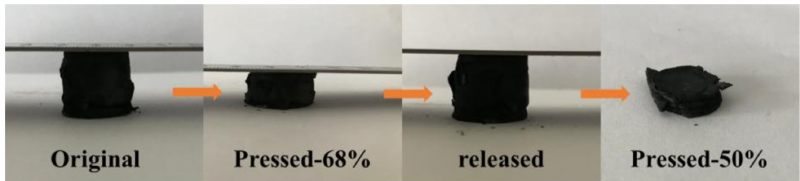
Figure 9. Recoverable deformation of aerogels without heat